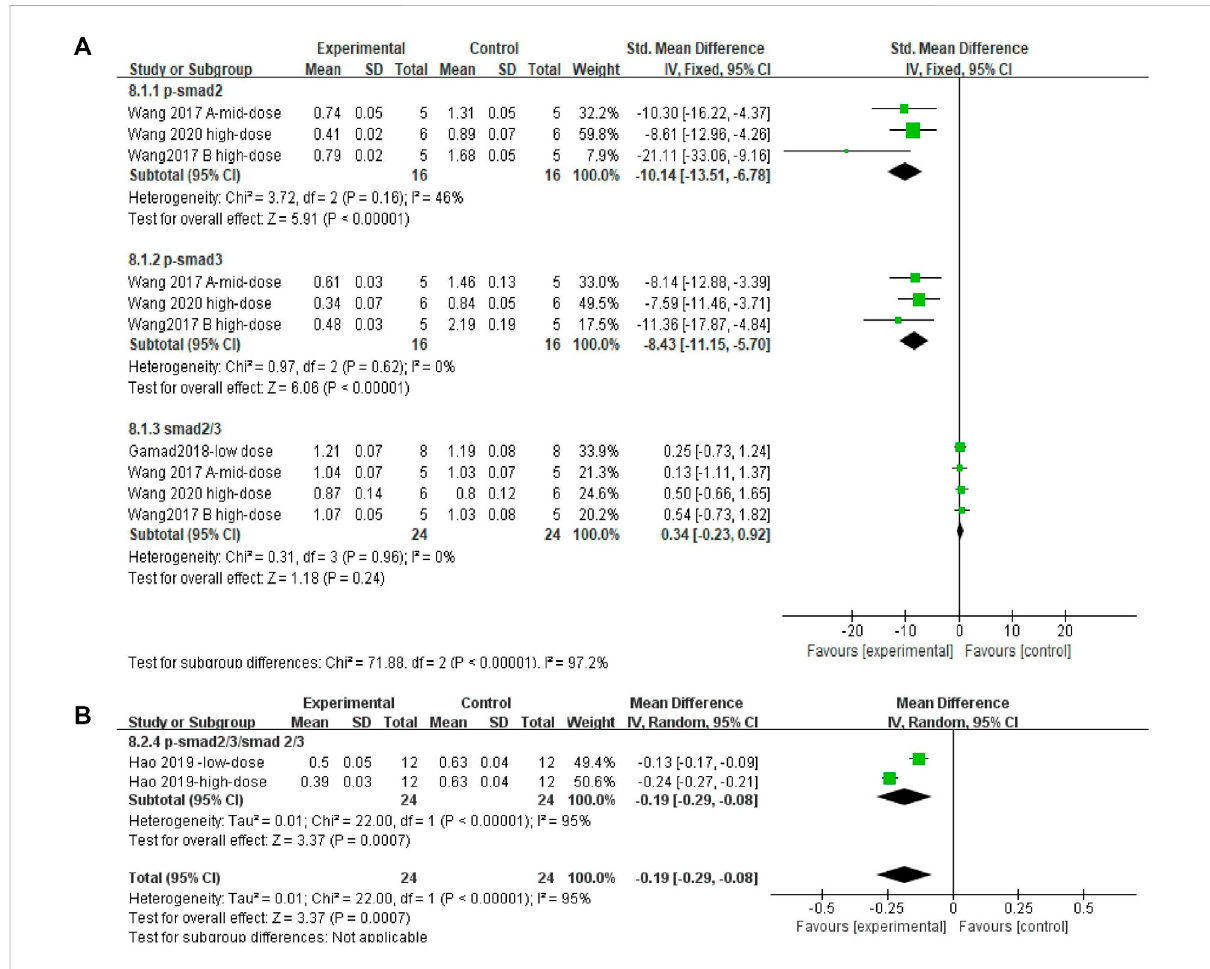
FIGURE 10 EffectofMETonSmadinlungtissuesofPFanimals. (A) Forestplotofp-Smad2,p-Smad3,andSmad2/3; (B) Forestplotofp-Smad2/3/Smad2/3.